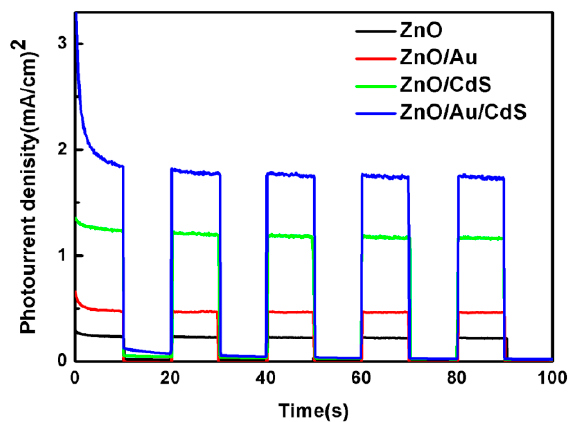
Figure 6. Transient photocurrent response of ZnO, ZnO/Au, ZnO/CdS and ZnO/Au/CdS sample.